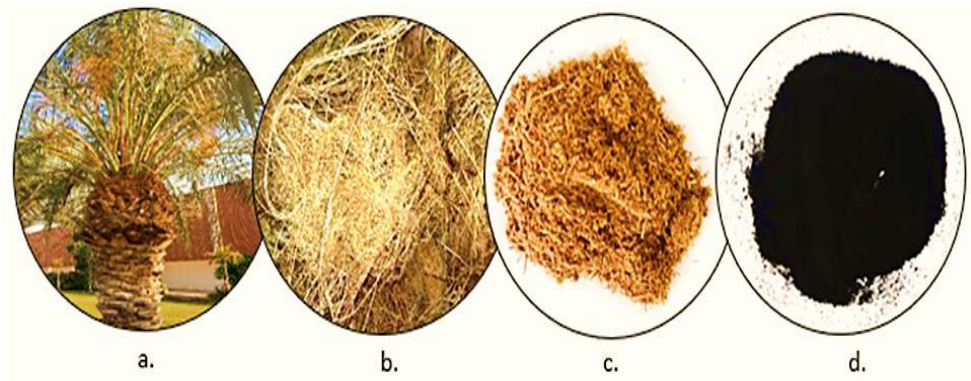
Figure 1. ( a ) Date palm tree, ( b ) Palm fibers, ( c ) Palm fibers powder, and ( d ) Activated carbon